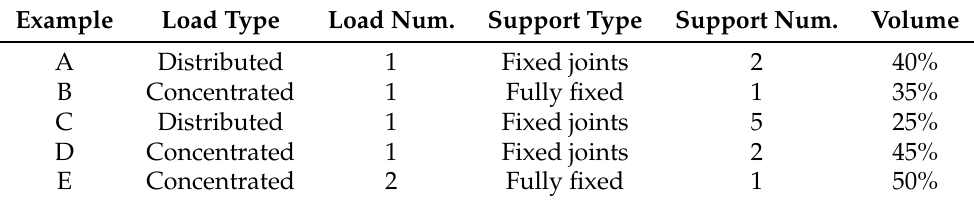
Table 1. Test examples